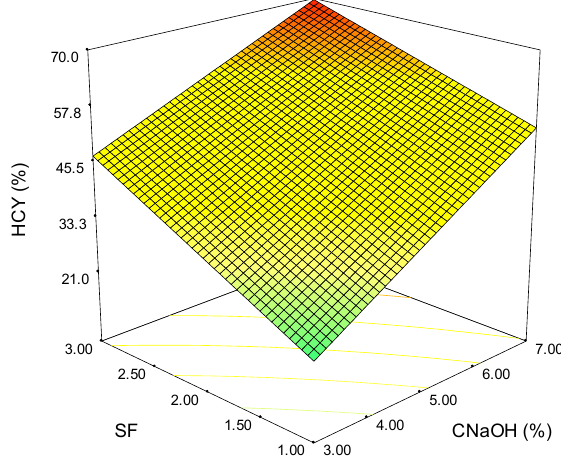
tration (the colours green-yellow-red indicate the shift from low to high values).